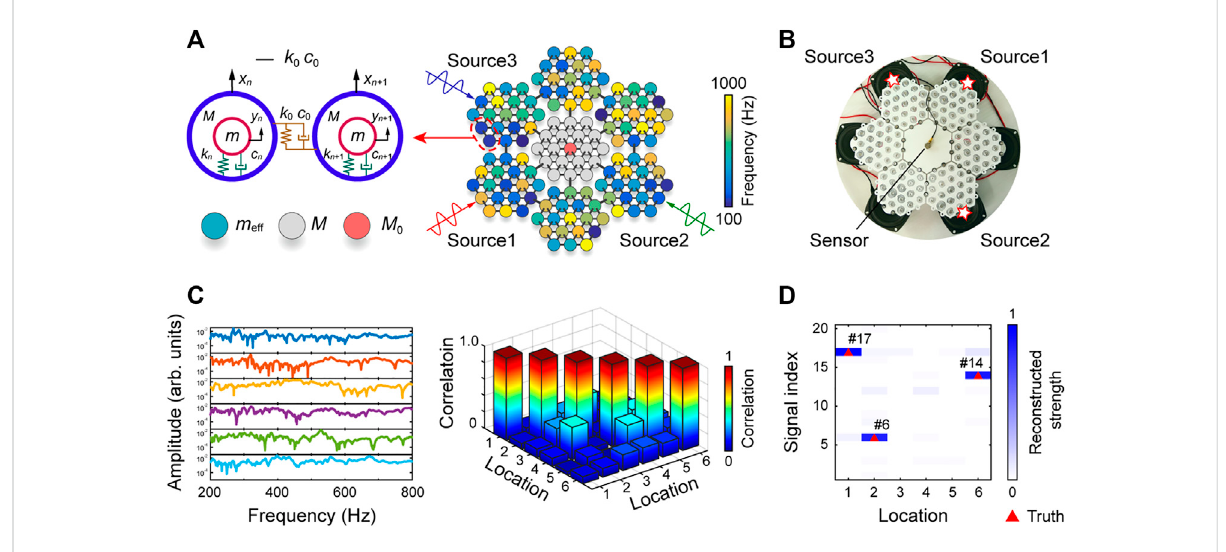
FIGURE 8 Randomized resonant metamaterial for single-sensor vibration identi fi cation [75]. (A) The metamaterial with randomly coupled local resonators. (B) The design of the metamaterial. (C) The highly uncorrelated transmission. (D) A reconstruction result with three activated vibration